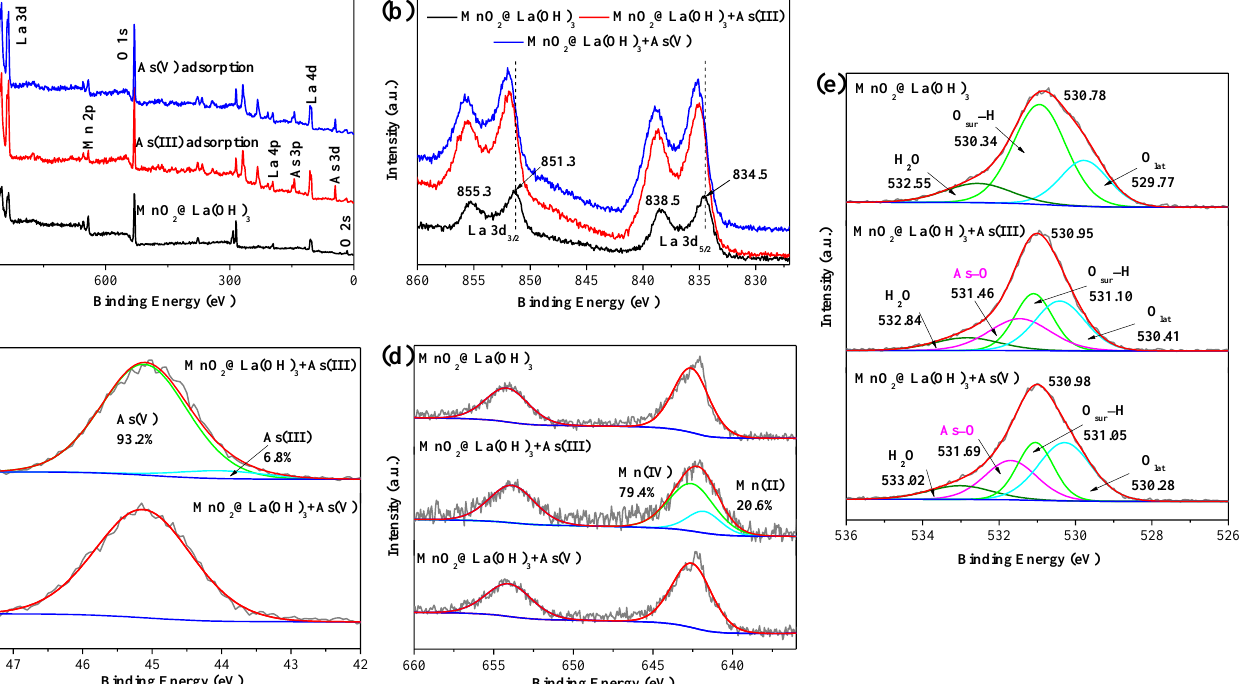
2+ were released into the solution and then δ -MnO 2 , a small amount of Mn